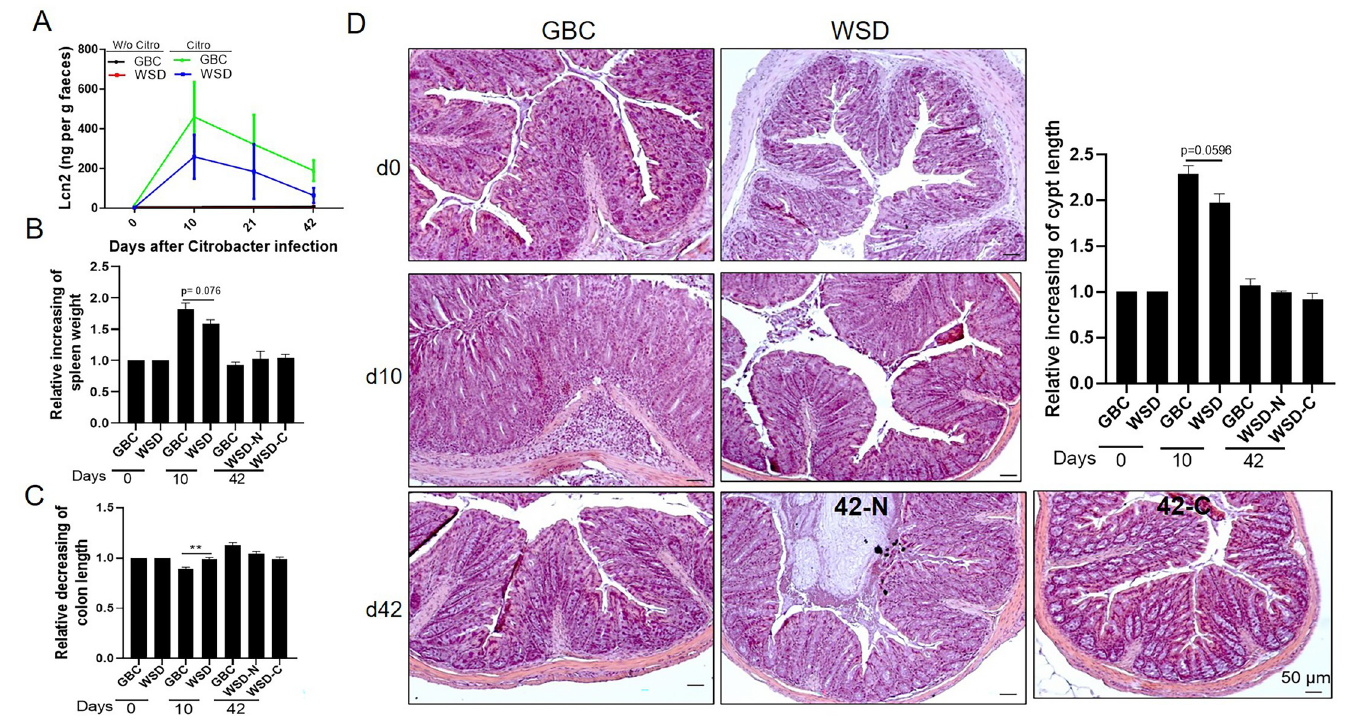
Fig 2. Reduced acute inflammation and lack of overt chronic inflammation in WSD-fed mice challenged with C . rodentium . C57BL/6 mice were administered PBS or C . rodentium and euthanized at the indicated time points. A. Measurement of fecal lipocalin 2 by ELISA. B-C . Spleen weight and colon length was measured in GBC and WSD fed mice that had (WSD-C) or lacked (WSD-N) detectable fecal C . rodentium CFU, and the relative fold change of spleen and colon were normalized to day 0 values of mice fed with the respective diet. D-E . Colon tissue was processed for H&E staining, which afforded measure of colon crypt length, and expressed as relative fold changes to day 0 values of mice fed with the respective diet. Data are the means +/- SEM (n = 5–10 mice per group) of an individual experiment and representative of 2–3 separate